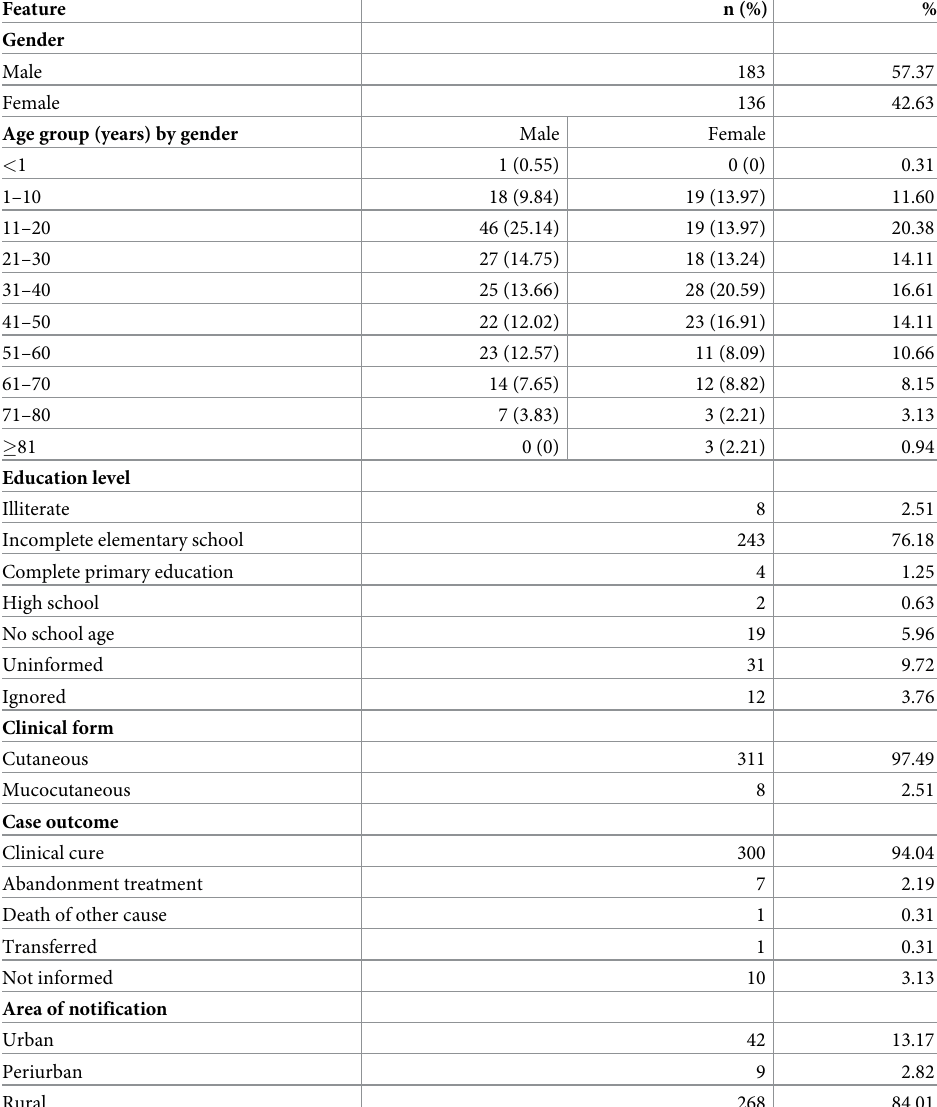
Table 1. Demographic and clinical features of ATL cases in the municipality of Caratinga